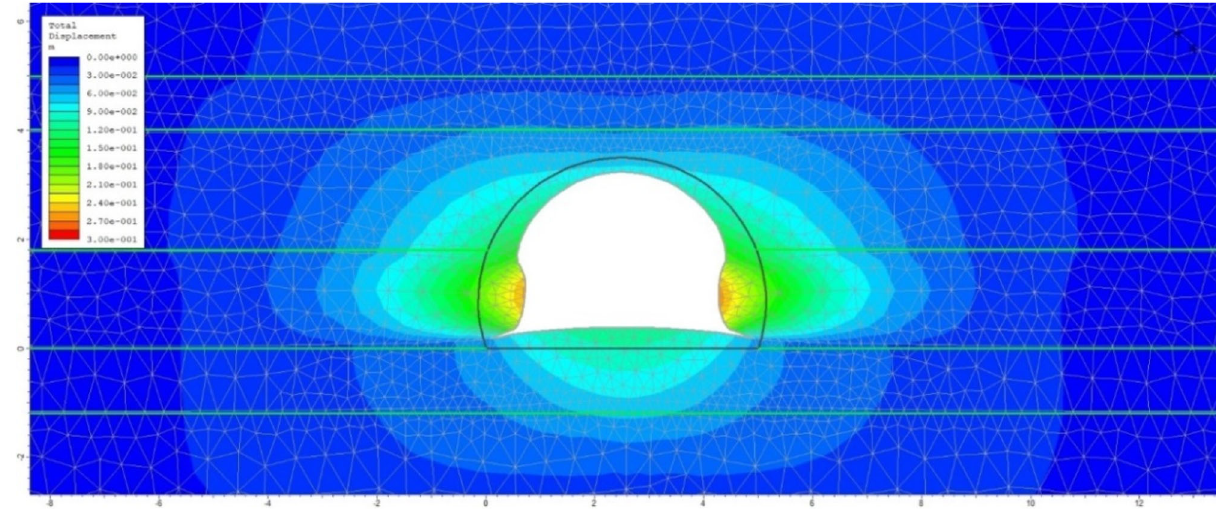
Fig. 16 Total displacement of Case